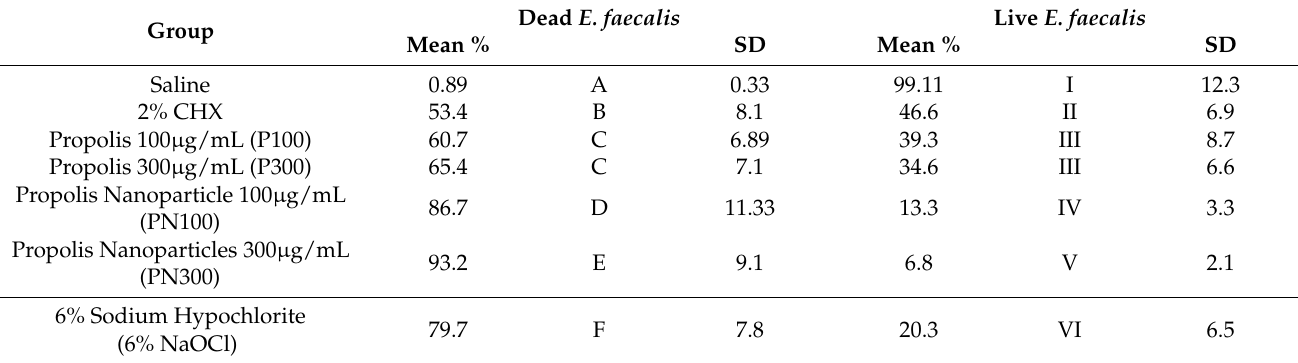
Figure 3. Representative images of ( A ) 2% CHX, ( B ) 6% NaOCl, ( C ) P100, ( D ) saline, (E) P300, and ( F ) PN300 treated on dentin samples. Confocal images of (G) saline, ( H) 2%CHX, ( I ) 6%NaOCl, ( J ) P100, ( K ) PN100, and ( L ) PN300 showing variations in effect on biofilm grown. Table 3. Bacterial viability in single-species E. faecalis biofilms following different disinfectant treatments. Dead E. faecalis Live E. faecalis Group Mean %